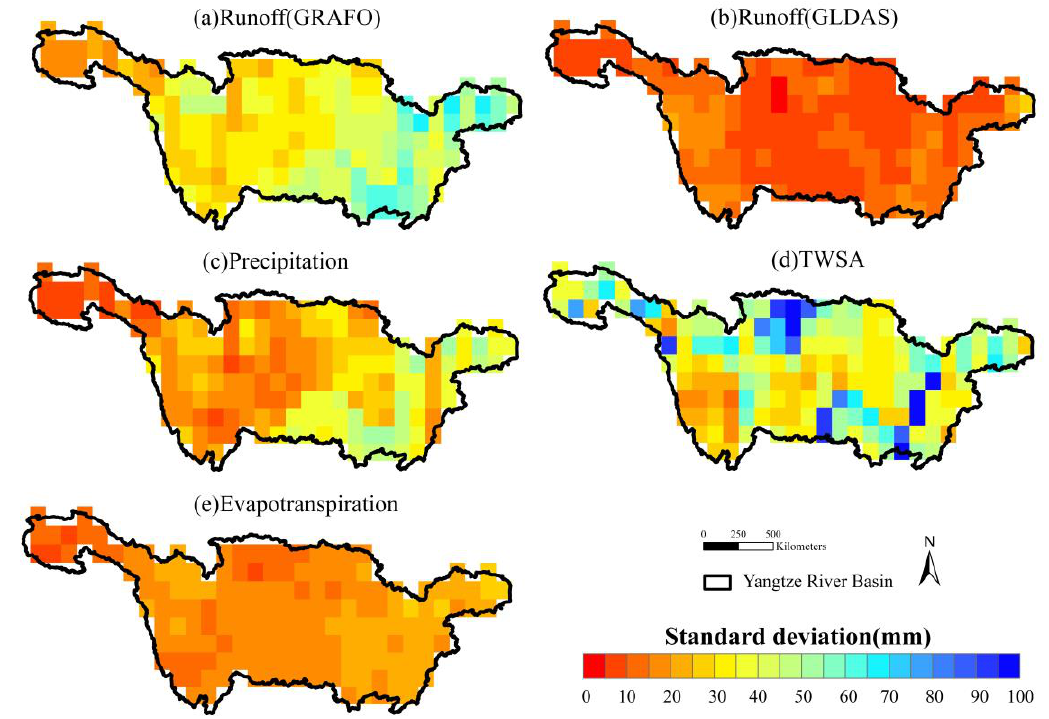
Figure 2. Time series of precipitation, evapotranspiration, and TWSA in the Yangtze River basin between June 2018 and October 2020, on which the shading area with different color represents the change range of different variables.